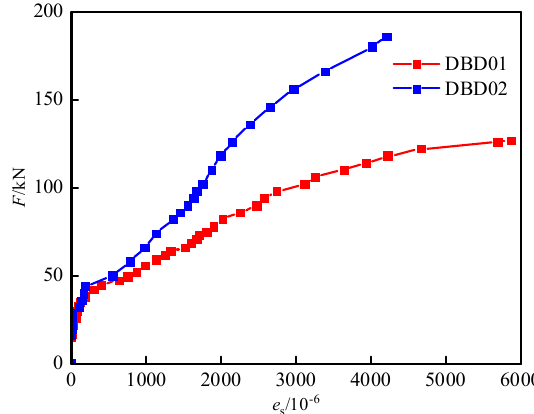
Figure 15. Load versus strain curve of reinforcement.